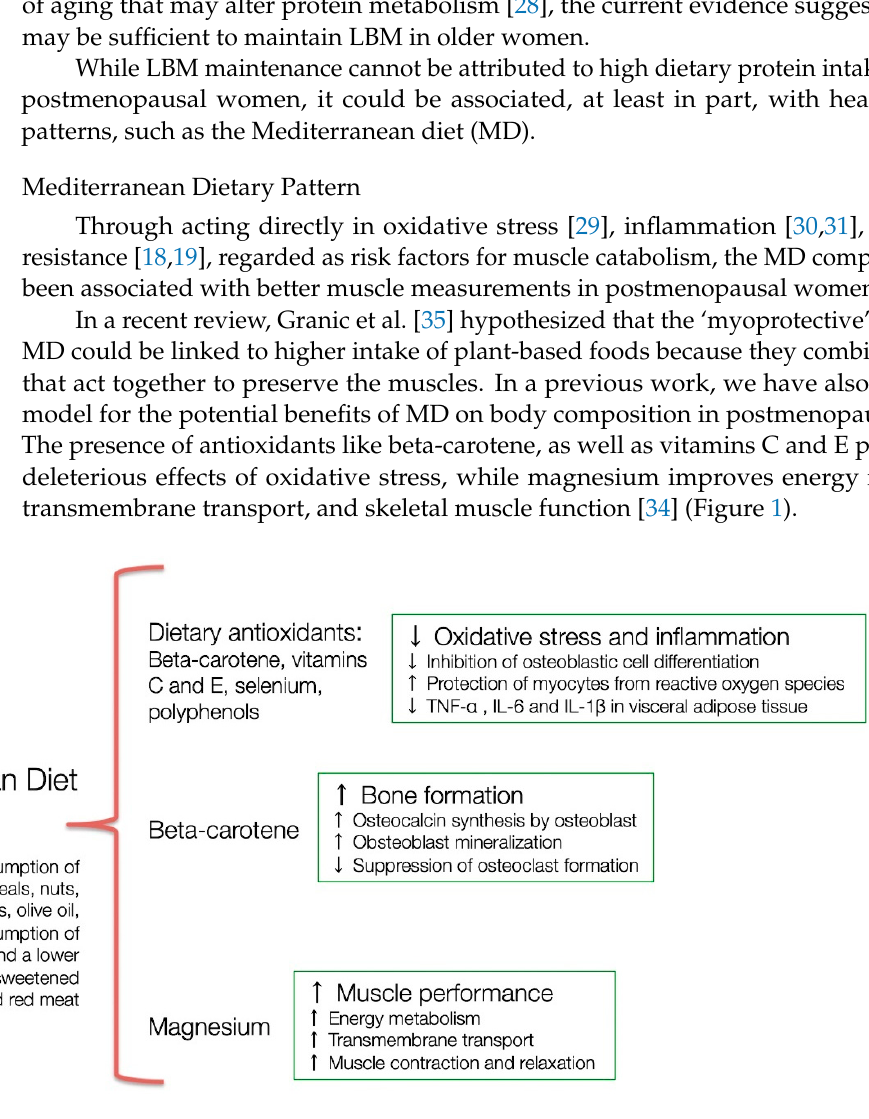
Figure 1. Potential benefits of Mediterranean diet on body composition in postmenopausal women. Redrawn and modified from [34].